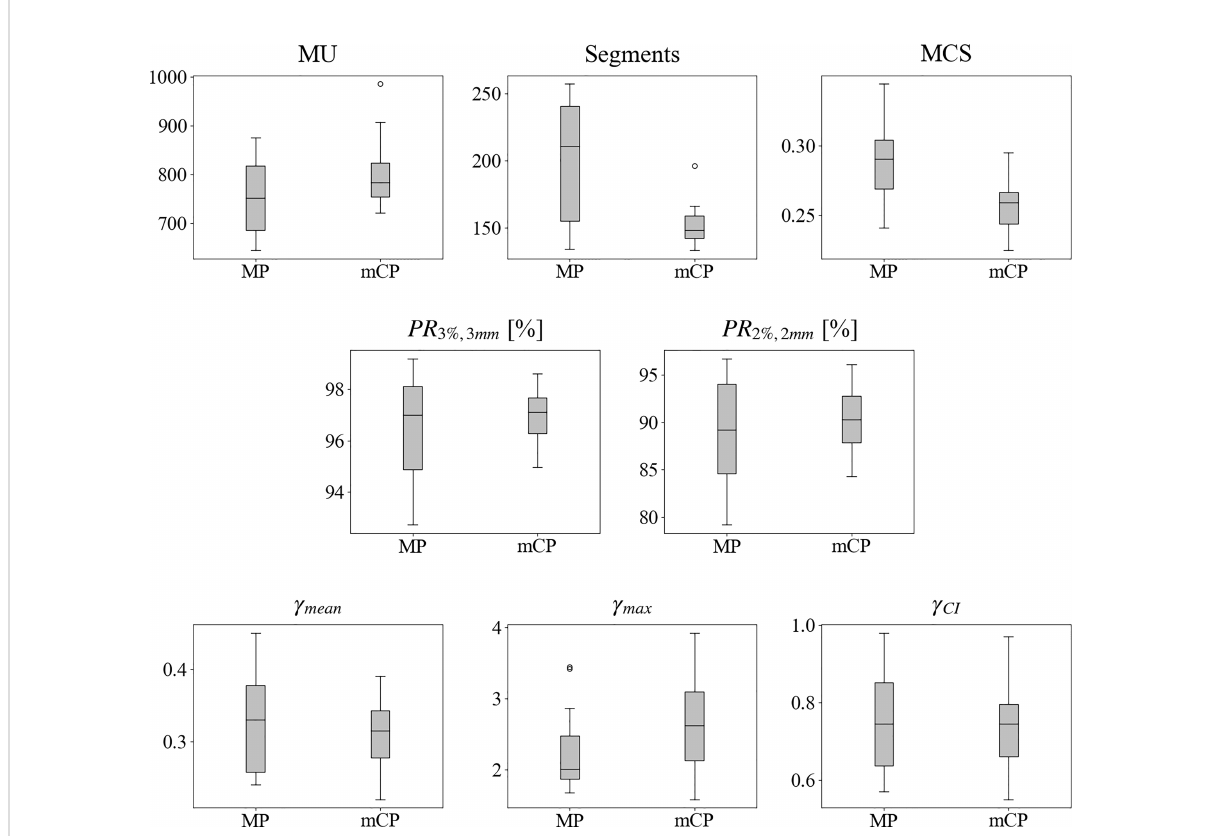
FIGURE 4 Box-and-whisker plots of computed complexity and delivery metrics for manual plans (MP) and mCycle plans (mCP). The box is delimited by the fi rst (25%) and the third (75%) quartiles, and the bold line represents the median value. The whiskers point to the minimum and maximum data without counting boxplot outliers that in case there exist are represented with circles. An outlier is de fi ned as a value exceeding the 1.5 interquartile range (1.5 (third – fi rst quartile)). Abbreviations: MP, manual plans; mCP, mCycle plans; MU, monitor units; MCS, modulation complexity score; PR_33, 3%/3 mm gamma passing ratio; PR_22, 2%/2 mm gamma passing ratio; ɣ mean , mean gamma index value; ɣ max , maximum gamma index value; ɣ CI , gamma con fi dence